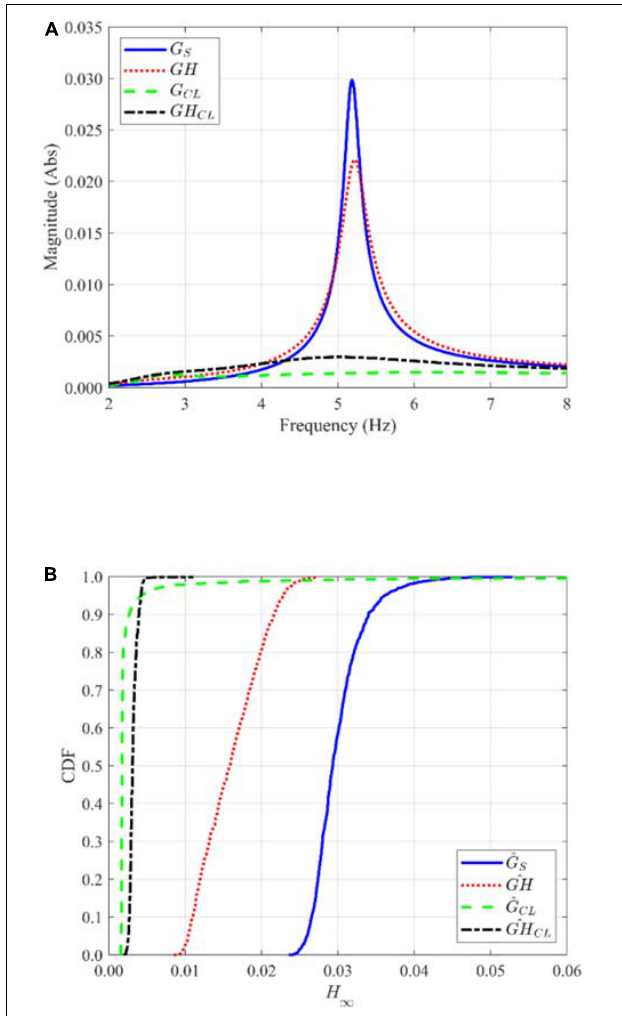
FIGURE 11 | AVA performance: (A) TFs for nominal values, and (B) CDF curves due to uncertainties in the systems.